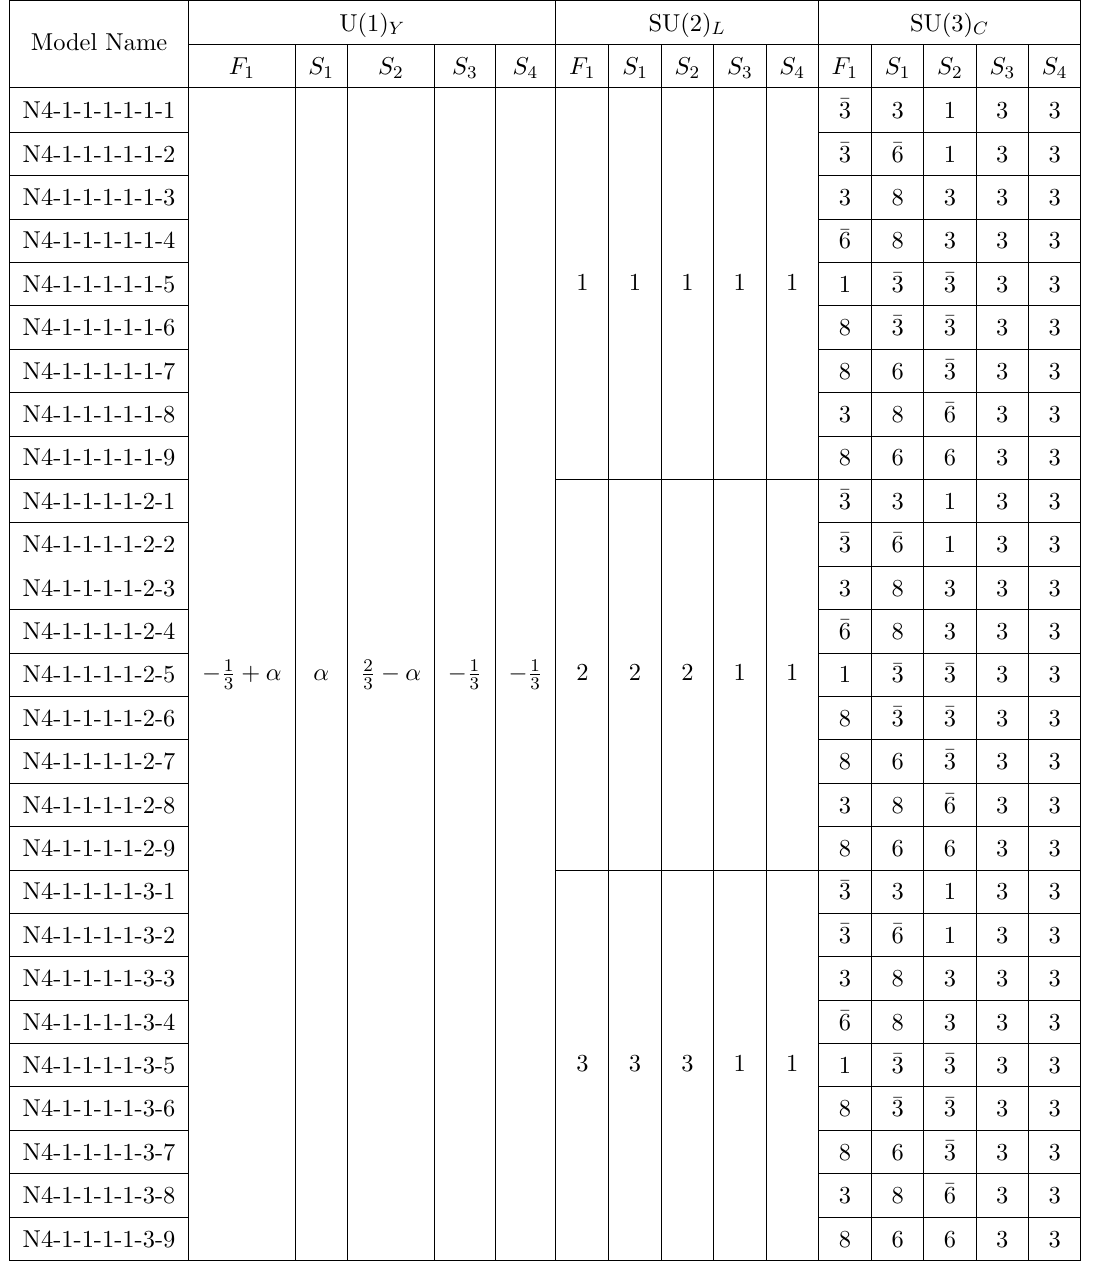
Table 6 . The one-loop models for the 0 νββ decay operator N4 arising from the diagram N4-1-1-1-1 shown in figure